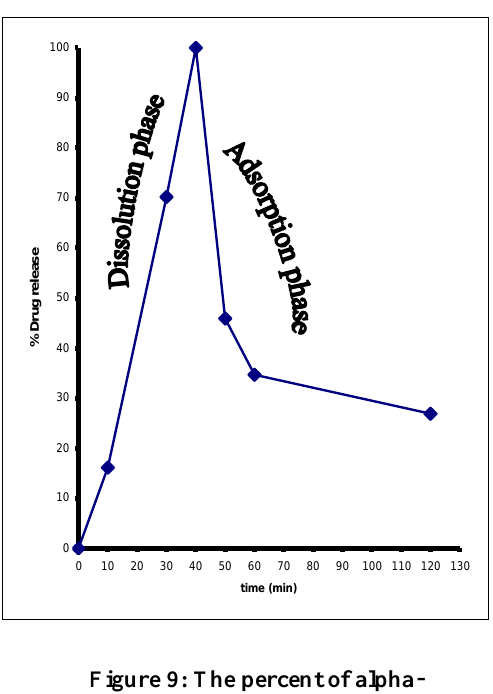
Figure 9: The percent of alpha- tocopherol acetate released from microcrystalline cellulose at pH 1.2 after 3 months of incubation